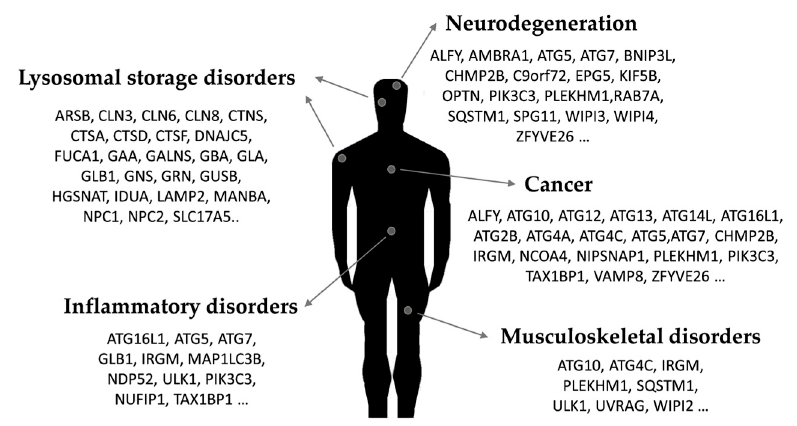
Figure 1. Representative links between autophagy-related proteins and human pathology.